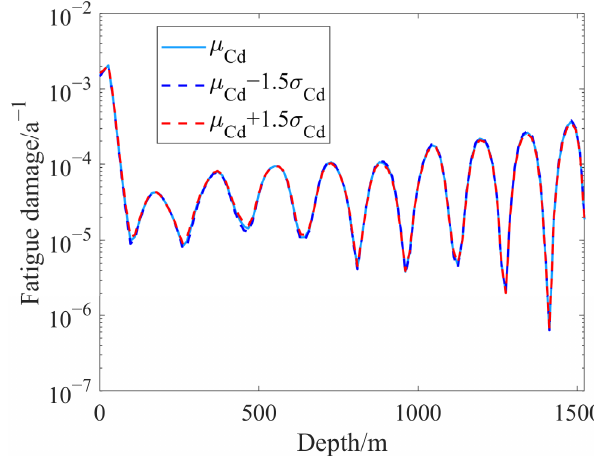
Figure 10. Effect of C on fatigue damage.